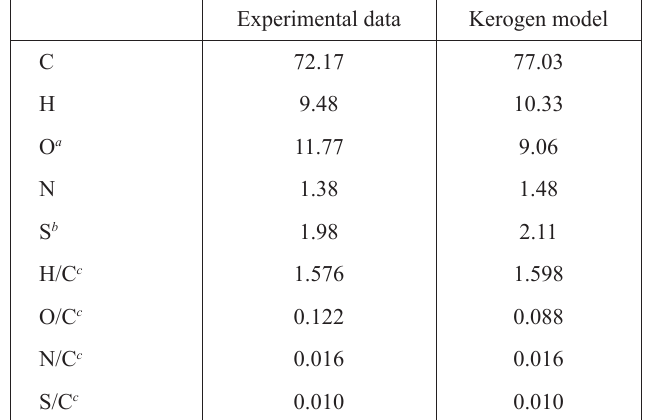
Table 1. Elemental composition of Dachengzi oil shale kerogen from experiment and the molecular model,